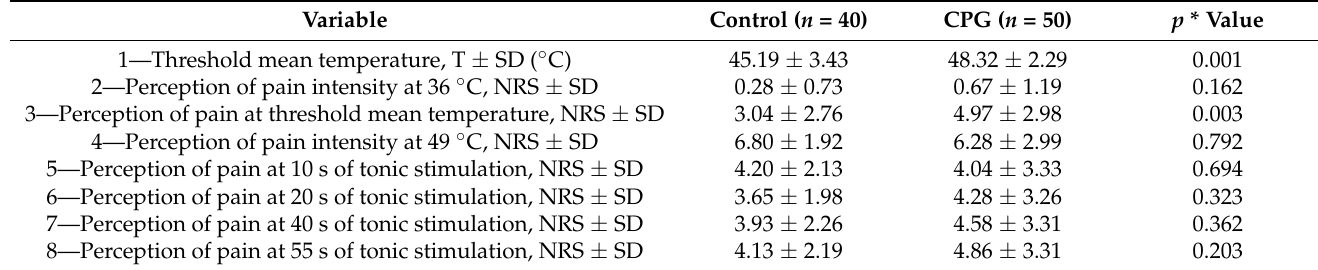
Table 2. Comparative analysis of the QST variables between the control group and the chronic pain group (CPG) ( n = 90).